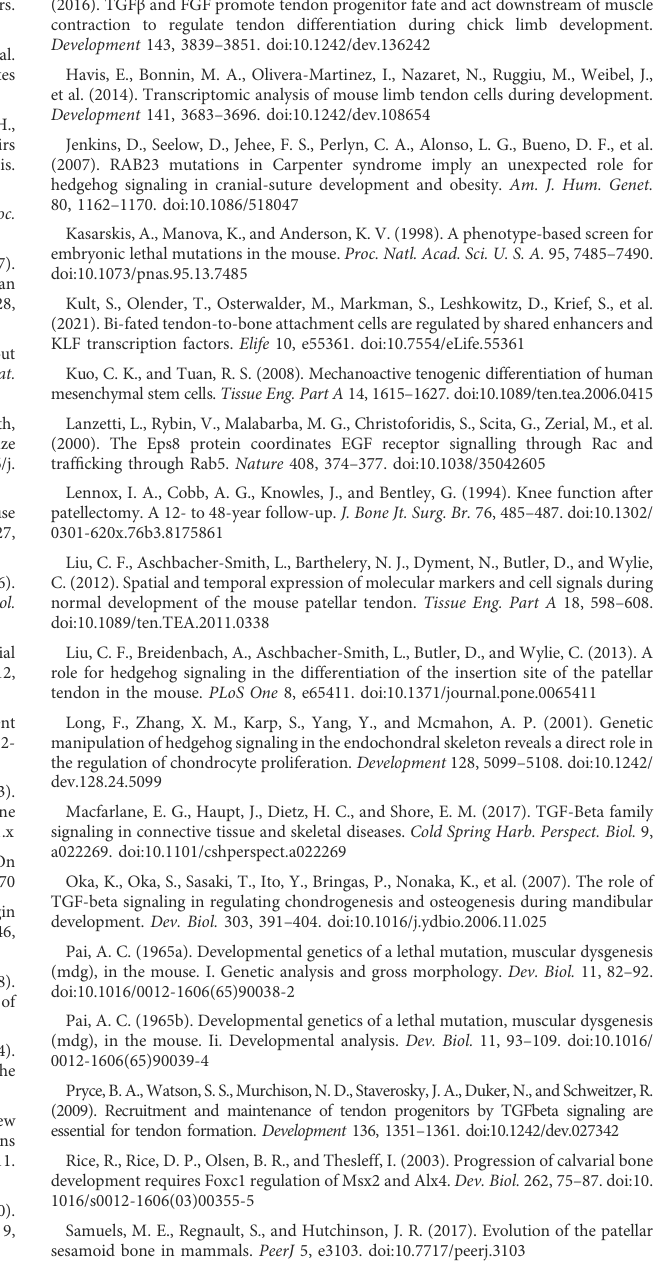
E18.5. Forelimbs of Rab23 − / − mouse has a poorly formed deltoid tuberosity in the humerus (arrow). h: humerus, r: radio, u: ulna, and dt: deltoid tuberosity. (n = 4 for each age and genotype). SUPPLEMENTARY FIGURE S6 Abnormal joints in Rab23 − / − hind limbs. Whole mount Alcian blue and alizarin red staining of Wt and Rab23 − / − mice hind limbs at E18.5. The rudimentary tibiofemoral joint is abnormal in Rab23 − / − mice (black arrows). In Rab23 − / − mice, the fi bula and tibia bones are attached to the head of the femur (black arrows, insets, upperand lower panels). The jointbetween the tarsal and the metatarsalisalsomorphologicallyabnormalwitharesultant fl exofthefoot in Rab23 − / − mice (insets, lower and upper panels, white arrows). (n = 4 for each age and